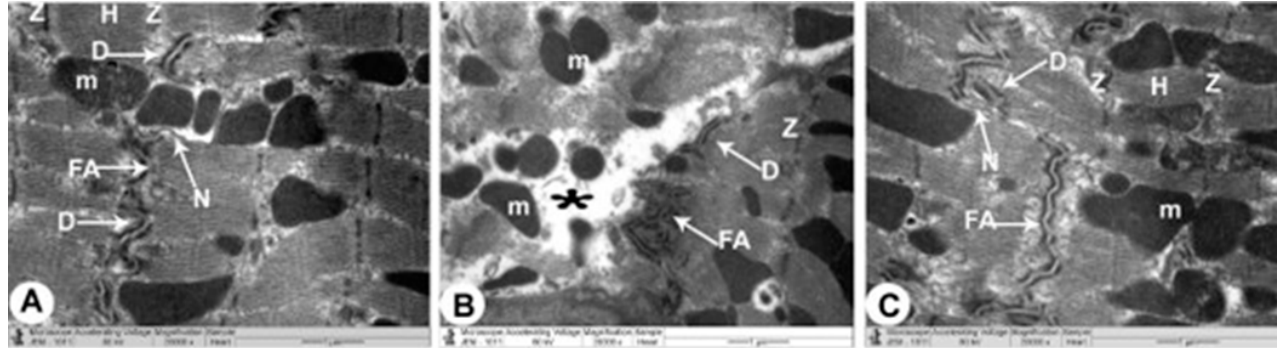
Figure 4. TEM micrographs of the intercalated disc from all groups. Control group ( A ) displays a healthy cardiomyocyte with abundant cytoplasm and healthy myofibrils, as well as a striated pattern with clear (Z and H) bands and undamaged mitochondria (m). Intercalated disc with characteristic fascia adherent (FA), desmosomes (D) and Gap (nexus) junctions (N) are also seen. The endotoxin group ( B ) exhibits disorganized myofibril cytoplasm with muscle (Z and H) band damage with pleomorphic mitochondria (m). Damaged intercalated discs with marked disruption of their constituents (fascia adherent (FA), desmosomes (D) and gap junction (Nexus) (N)) are also noticed. Endotoxin plus Vit C group ( C ) shows intact myofibrils, clear (Z and H) bands with a striated pattern, mitochondria (m) and intercalated discs (fascia adherent (FA), desmosomes (D) and Gap (nexus) junctions (N)) are also evaluated.